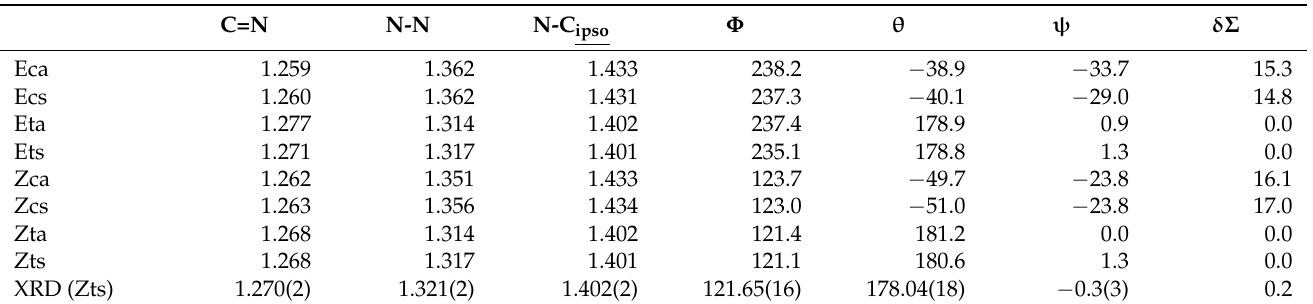
angstroms, planar and dihedral angles are in